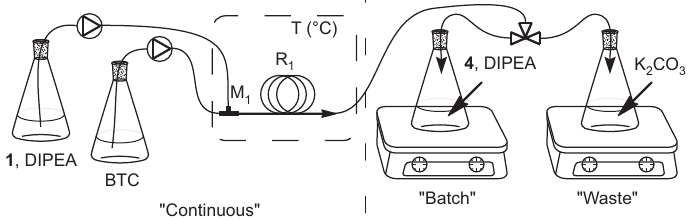
: l = 1 m, φ = 500 μ m, τ = 2 min, v = 8.33.10 -3 m · s -1 , 0.098 1